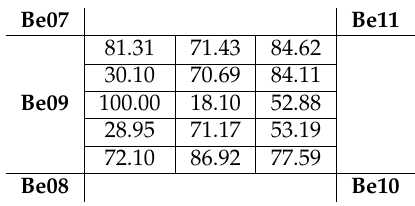
Table 4. Local accuracy in each sector of our experimental area with the most relevant transmission power level for k-NN using mode (with k = 5). The centre shows the accuracy (in %) of each sector. Corners and middle-left hand are the position of BLE4.0 beacons with BeXY name. The most relevant transmission power level was [4,1,2,1,1]. Be07